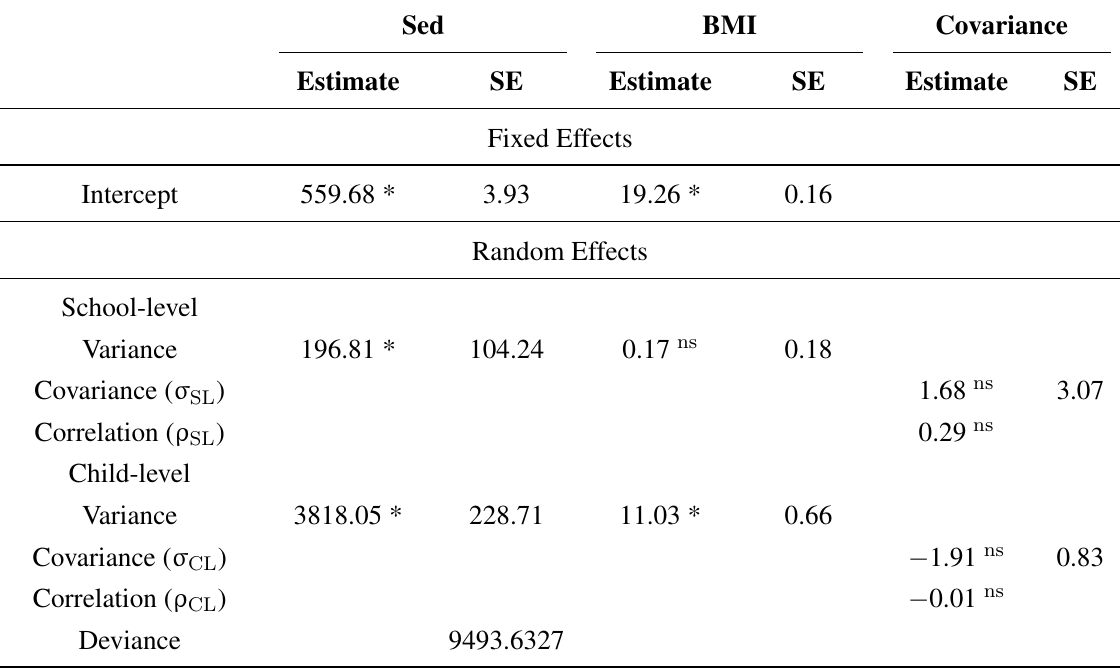
Table 2. Null model main results (parameter estimates, standard errors (SE) and deviance) for both sedentariness (Sed) and